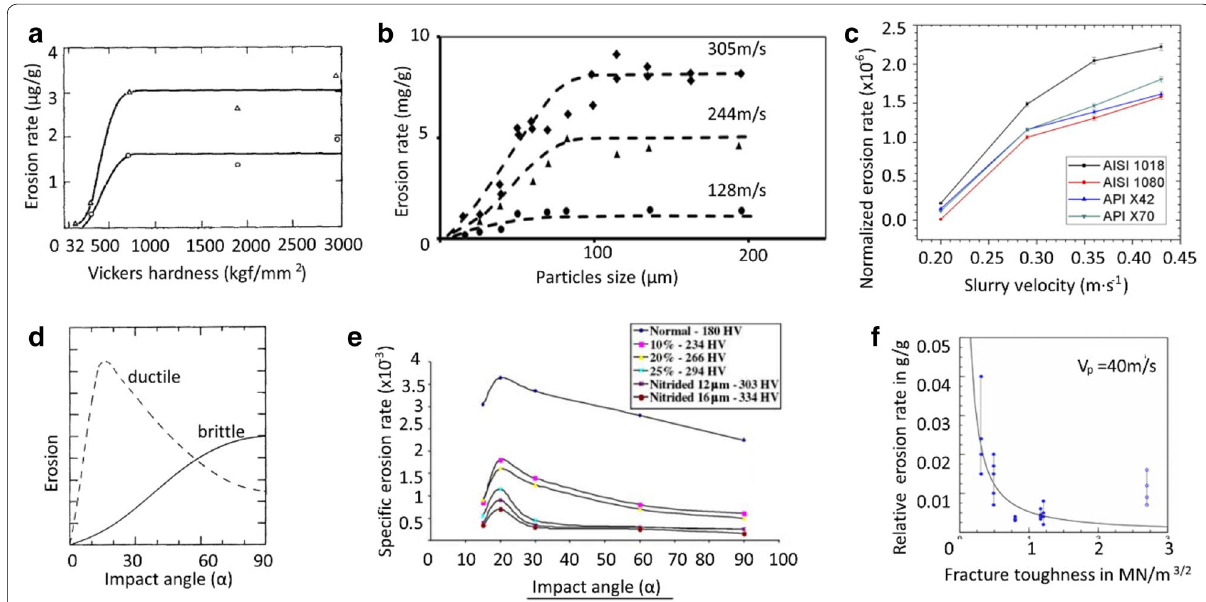
Figure 3 Schematic diagrams of the influence of different factors on the erosion rate: ( a ) Particle hardness (impact angles of 30° and 90°) [44]; ( b ) Particle size (different impact velocities) [46]; ( c ) Impact velocity (different materials) [48]; ( d ) Impact angle (ductile and brittle materials) [49]; ( e ) Material hardness (different impact velocities) [52]; ( f ) Material fracture toughness